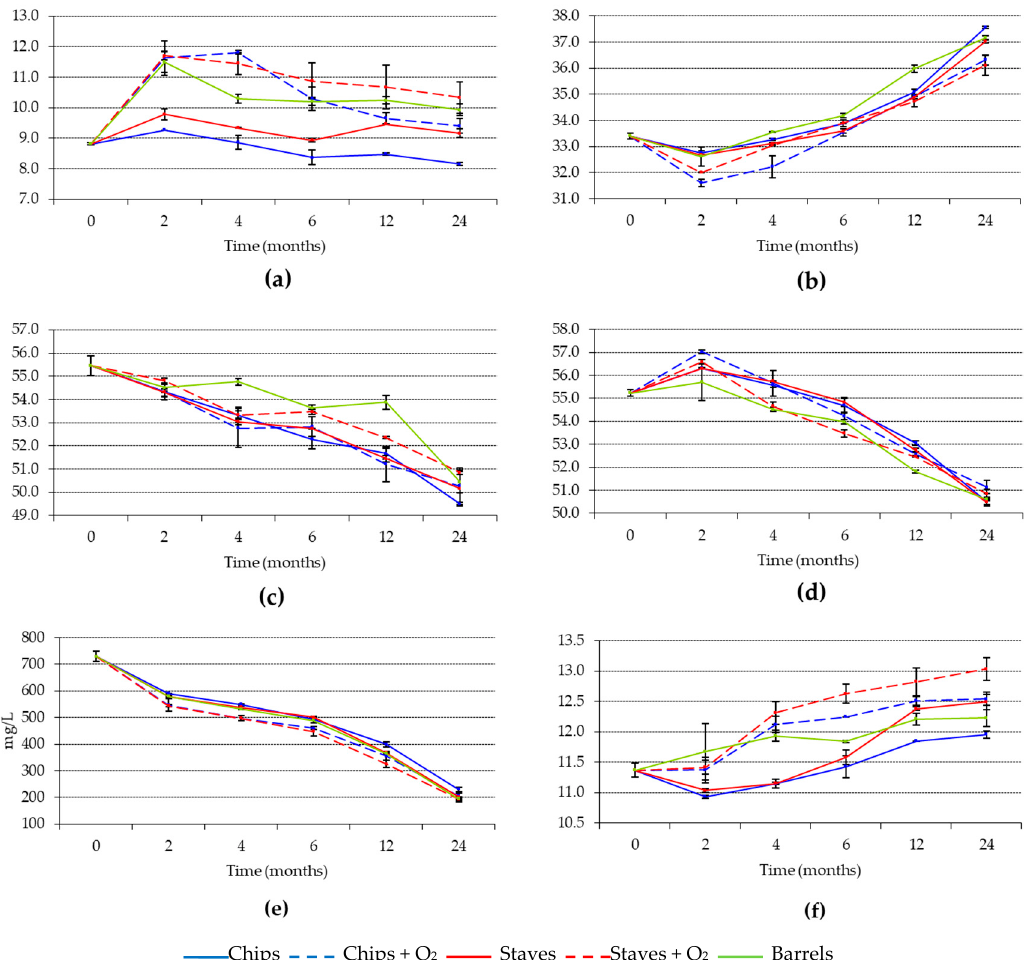
Figure 2. Evolution of the main chromatic parameters over time: ( a ) color intensity (CI); ( b ) percentage of yellow color; ( c ) total polyphenol index (TPI); ( d ) percentage of red color; ( e ) total anthocyanins (mg/L); and ( f ) percentage of blue color. Mean ± standard deviation ( n = 2).